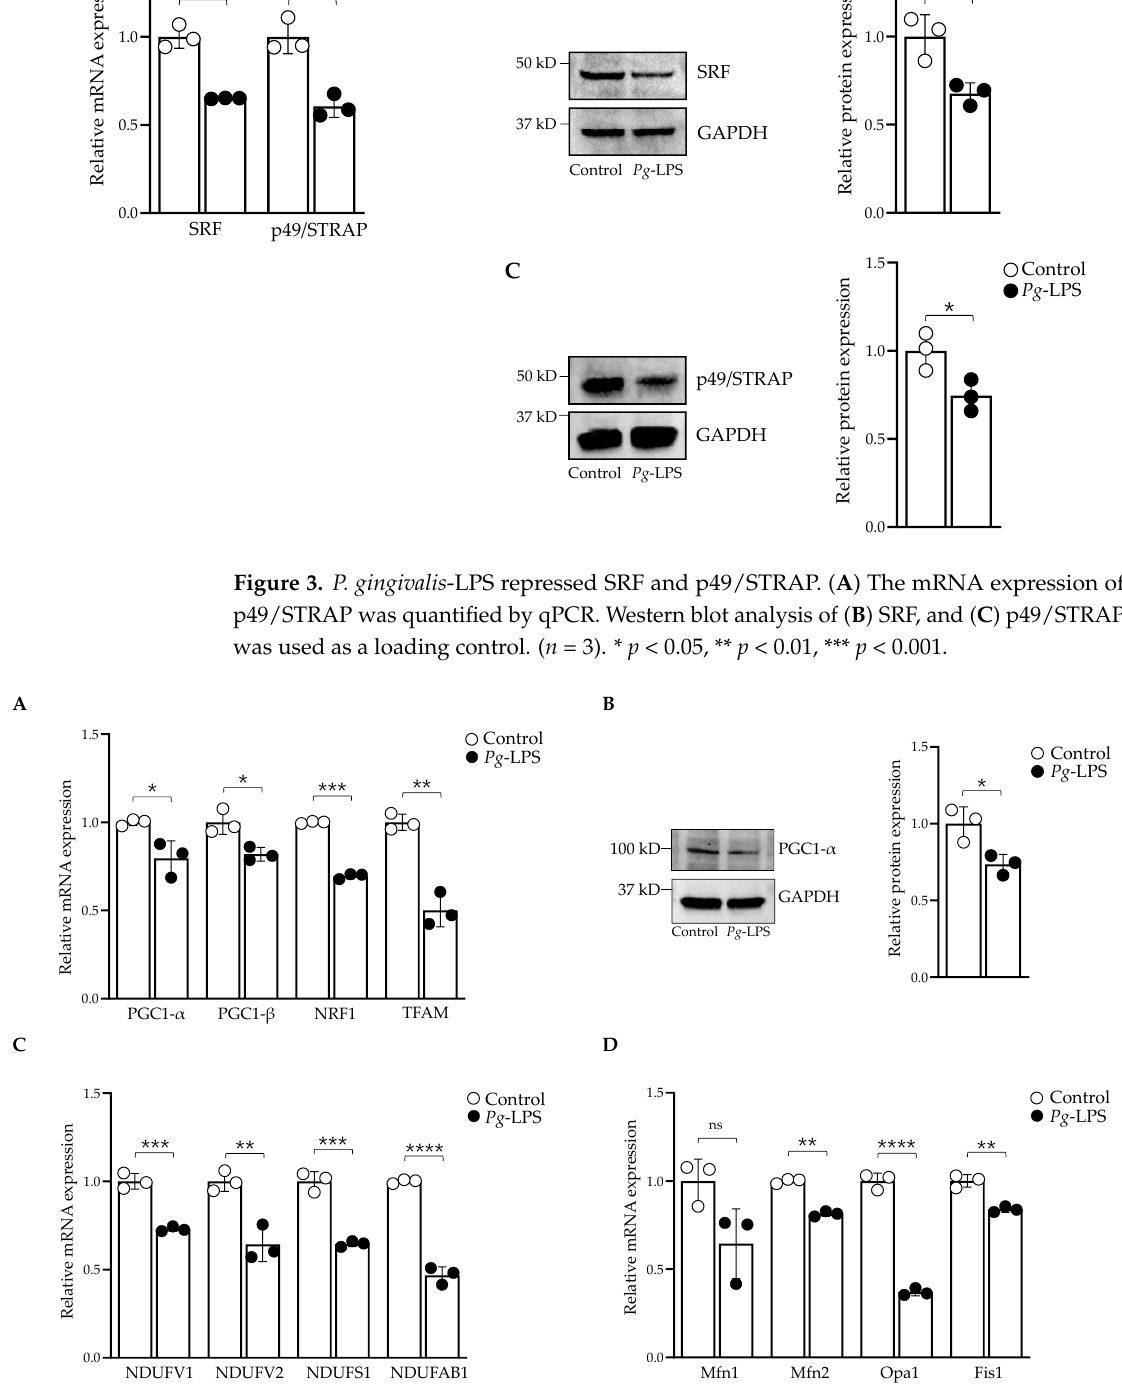
Figure 4. Downregulation of mitochondrial genes involved in biogenesis, fission, and fusion. ( A ) RT-qPCR analysis of PGC- 1α , PGC- 1β, NRF1 and TFAM ( B ) Western blot analysis of PGC- 1α . GAPDH was used as a loading control. ( C ) RT-qPCR analysis of mitochondrial complex-I genes. ( D ) Mfn2 , Fis1 and Opa1 genes were downregulated ( n = 3). * p < 0.05, ** p < 0.01, *** p < 0.001, **** p < 0.0001, ns: p > 0.05.